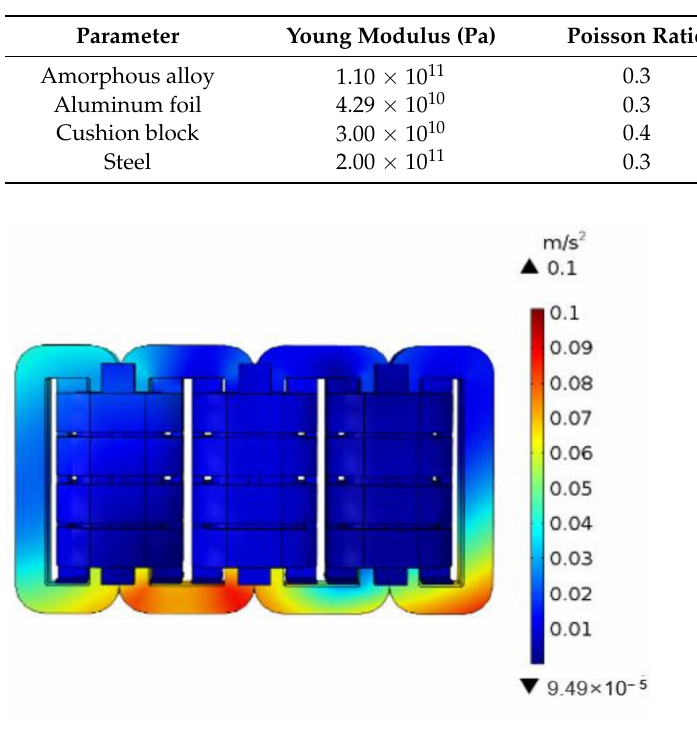
Table 1. Material parameters.